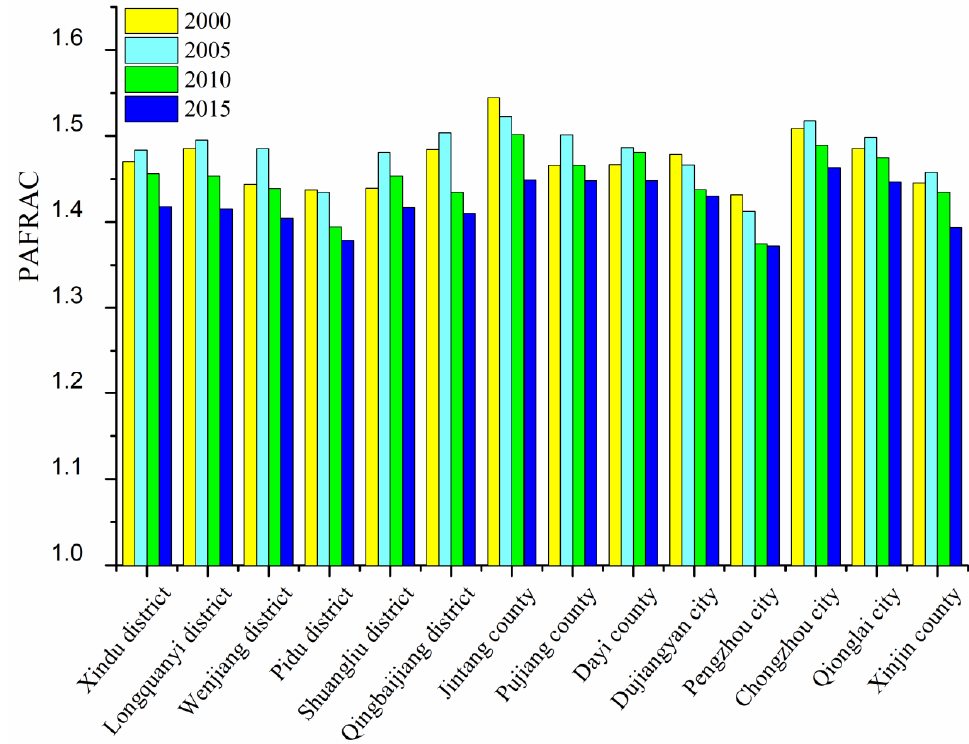
Figure 5. The PAFRAC of built-up land from 2000 to 2015.